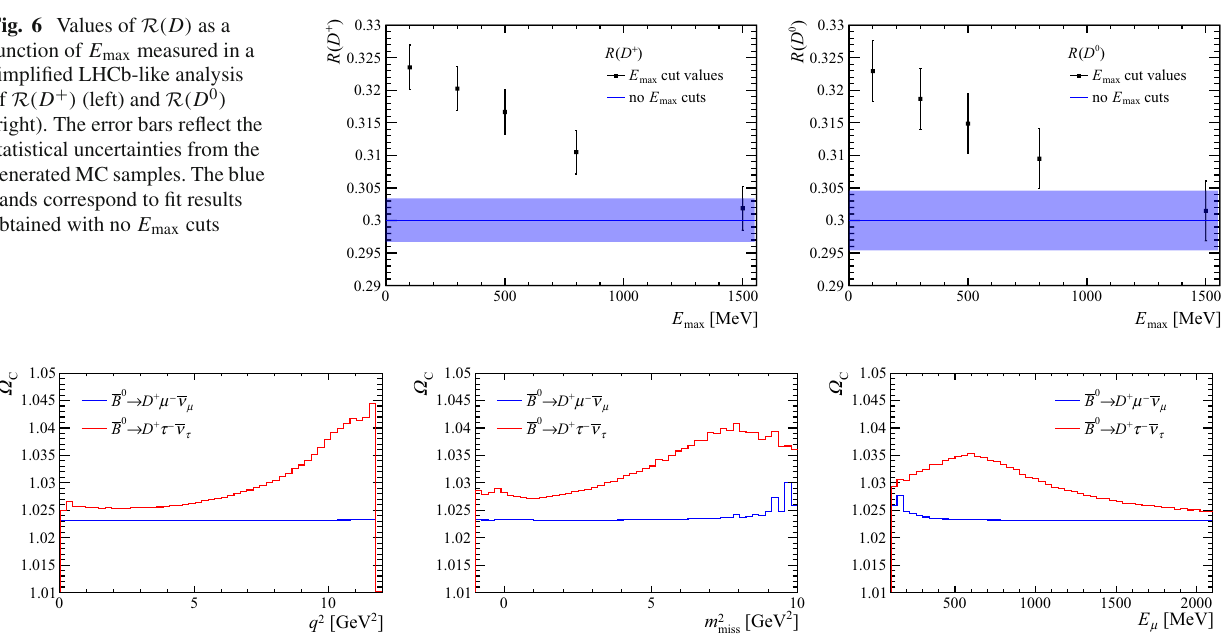
Fig. 7 Coulomb correction as a function of q 2 , m 2 , and E μ for B 0 → D + (cid:2) − ν (cid:2) decays, where (cid:2) − = μ − ,τ − miss mental precision expected in the coming years. Also, these quantitative effects strongly depend on explicit or implicit cuts on radiative photons and must be carefully evaluated for each analysis measuring R ( D )